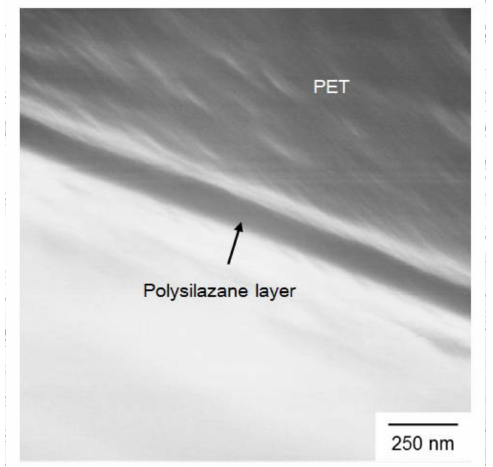
Figure 1. Cross-sectional SEM micrograph of the high-performance barrier film